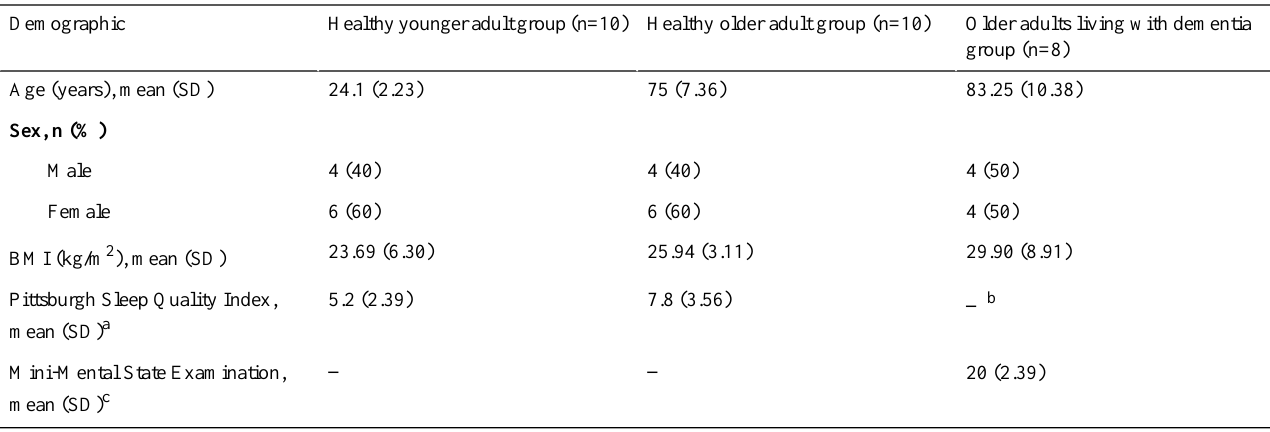
Table 2. Participants’demographics.